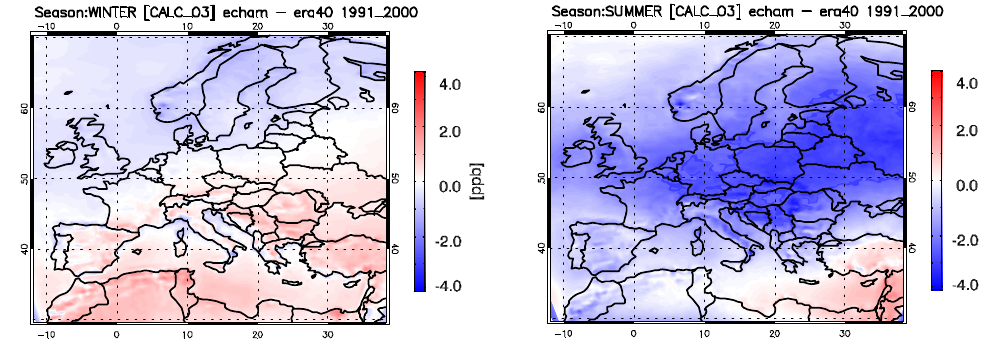
Fig. 9. Average surface O 3 fields calculated from the regression model for winter (left) and summer Figure 9. Average surface O3 fields calculated from the regression model for winter (left) and summer (right)